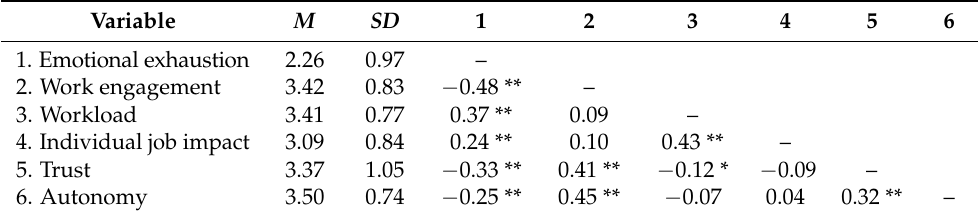
Table 1. Means, standard deviations and correlations of study variables.